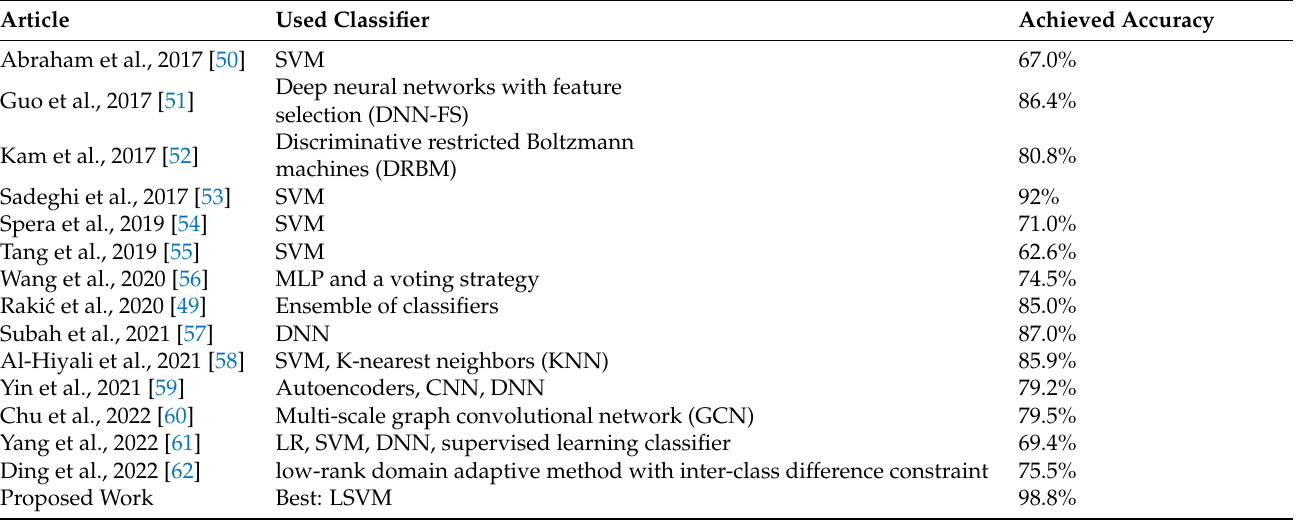
Table 6. Comparison of results of some existing ASD classification methods using the ABIDE-I dataset.